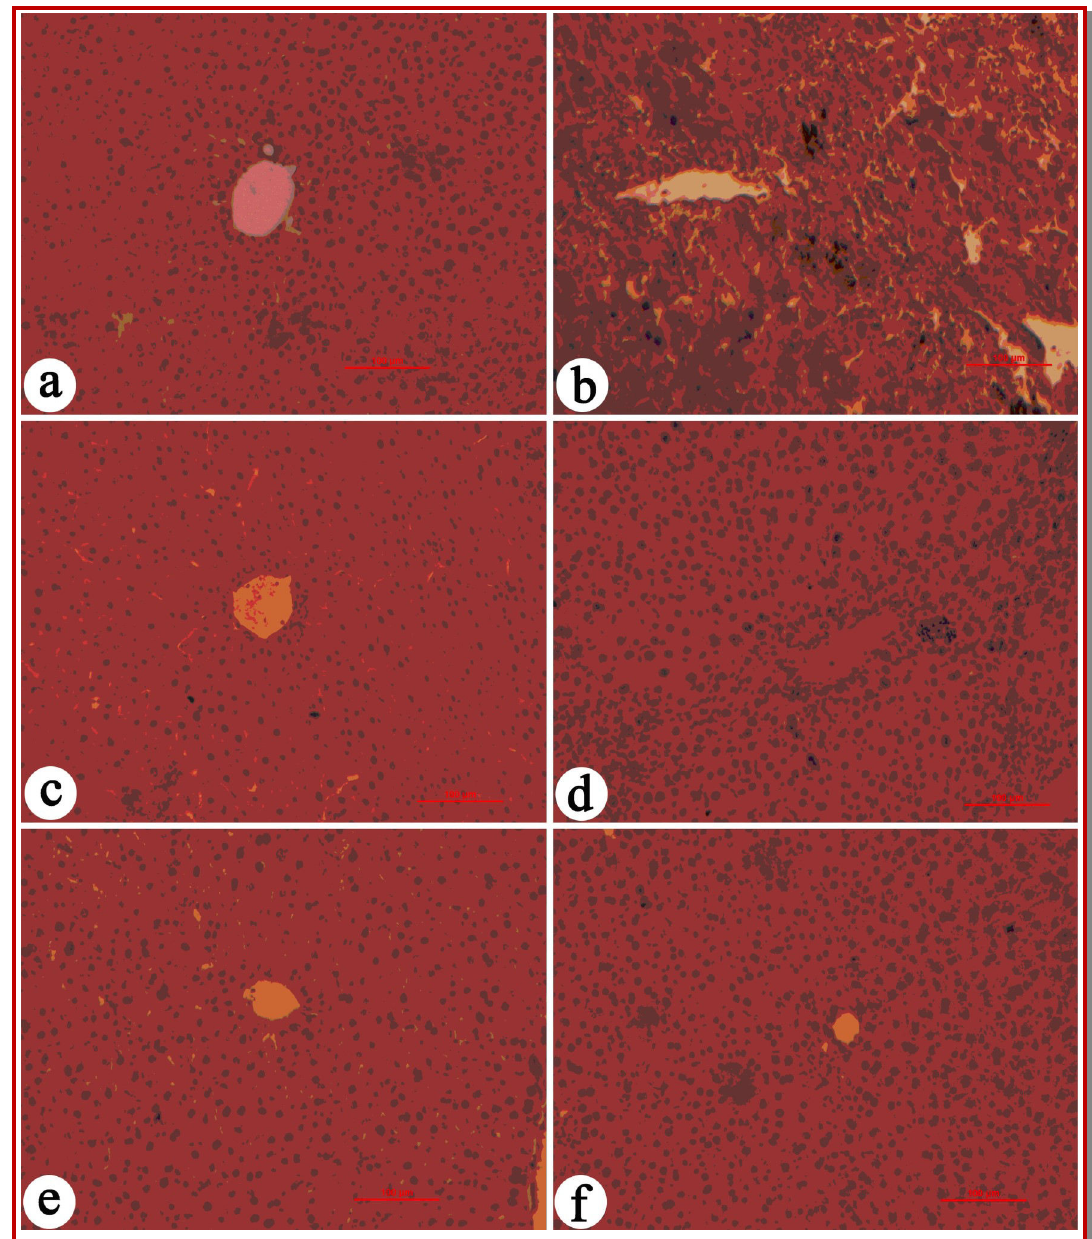
Figure 5: Sections of the livers of CCl 4 -treated rats showing the ventral vein (CV) and hepatic cells (hematoxylin-eosin staining, 200×) (a) Normal group, (b) control group, (c) CCl 4 + silymarin (100 mg/kg), (d) CCl 4 + TFI (100 mg/kg), (e) CCl 4 + TFI (200 mg/kg), and (f) CCl 4 + TFI (400